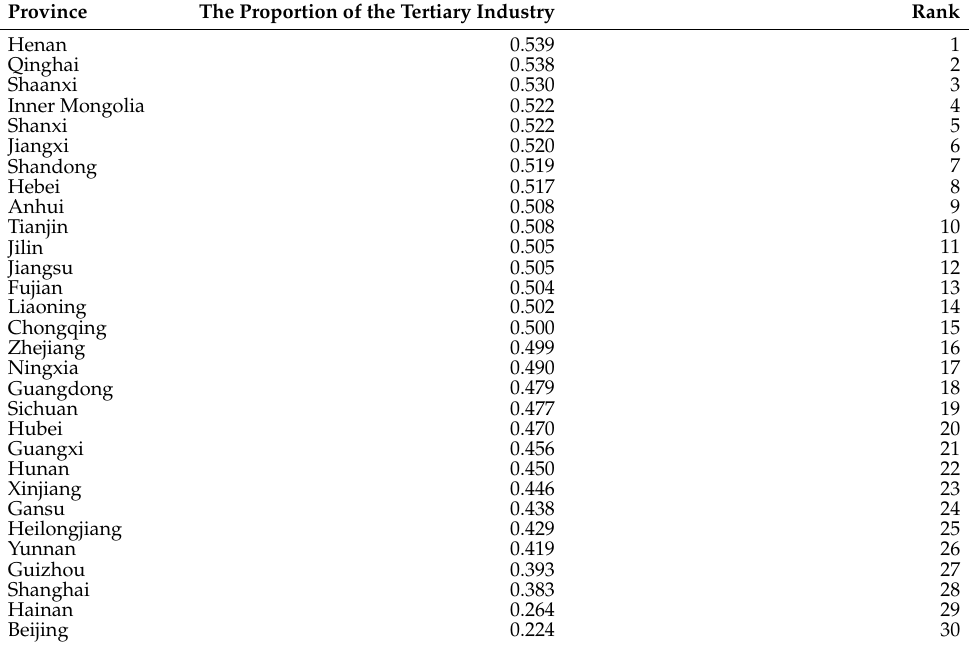
Table A14. The industrial structure (the proportion of the tertiary industry) rank of 30 provinces in